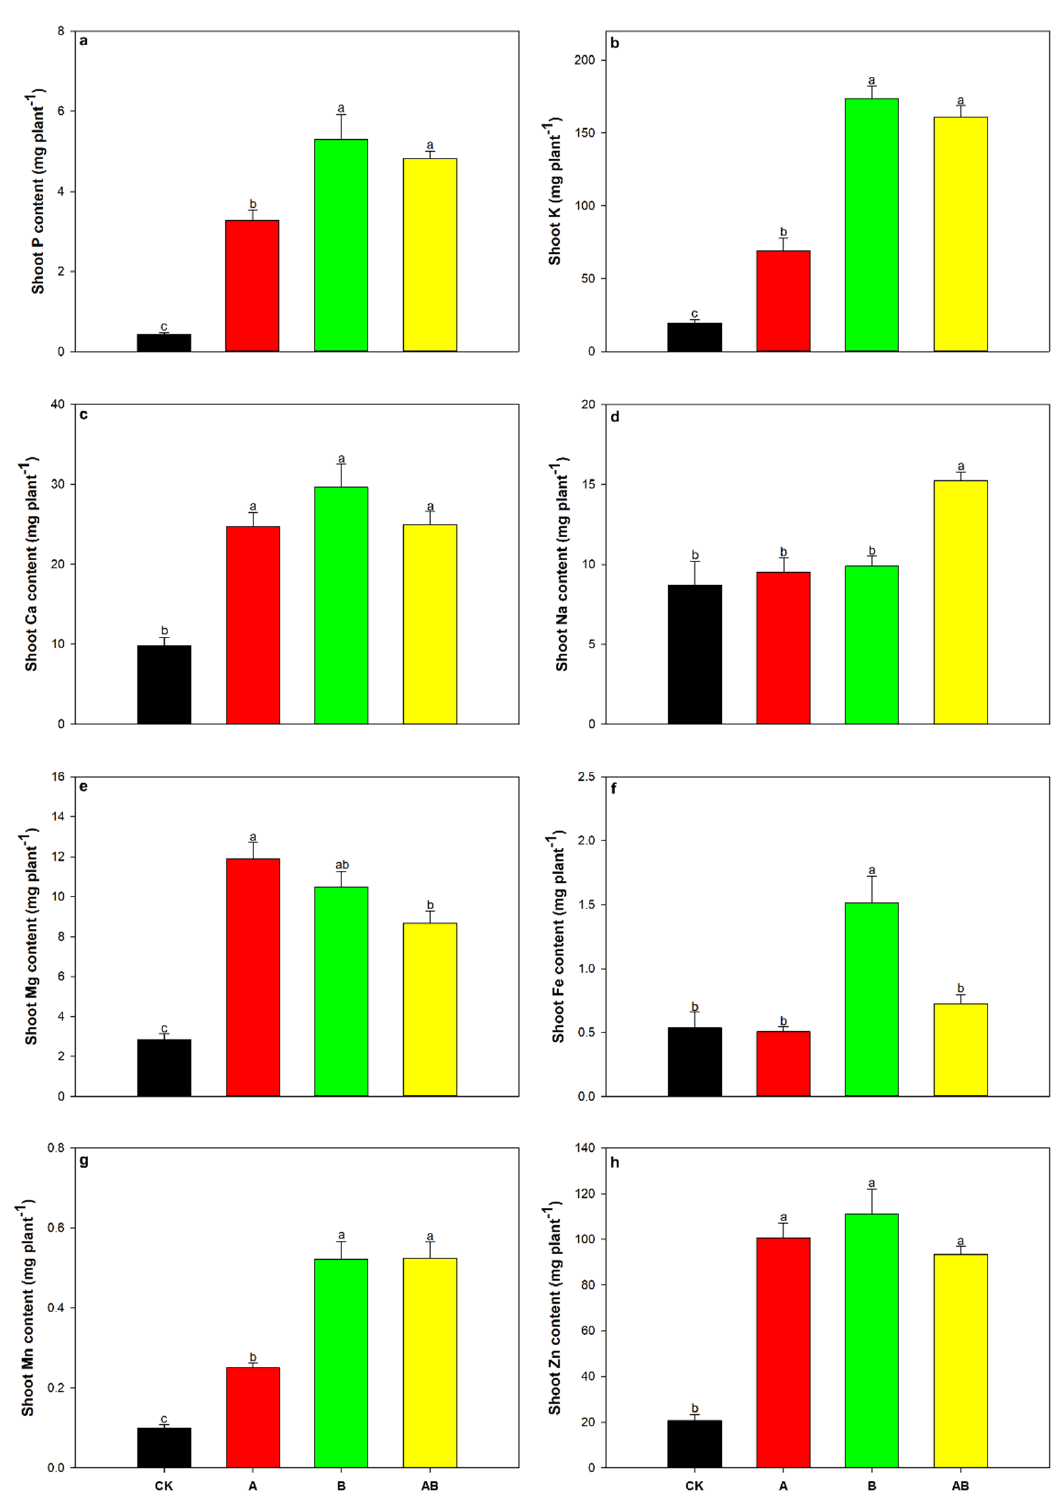
Figure 4. Effects of AMFs and biochar on shoot ( a ) P, ( b ) K, ( c ) Ca, ( d ) Na, ( e ) Mg, ( f ) Fe, ( g ) Mn, and ( h ) Zn contents. Data are means of five replicates ± SEs. Different letters above the columns indicate significant differences according to Duncan’s test at p < 0.05. CK, control; A, arbuscular mycorrhizal fungi; B, biochar; AB, arbuscular mycorrhizal fungi and biochar.